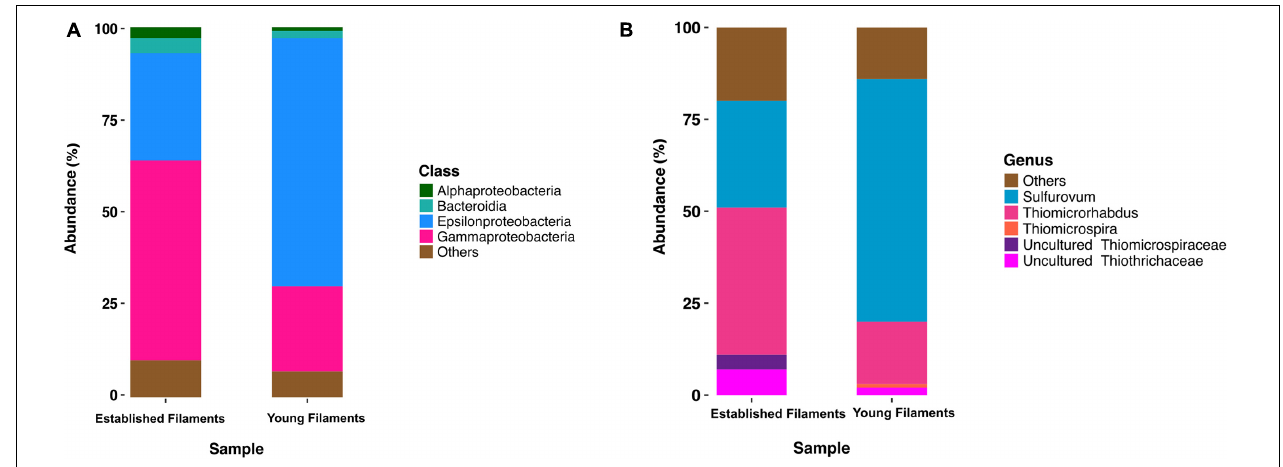
FIGURE 1 | Class (A) and genus (B) level distribution of 16S rRNA gene and transcript sequences recovered from established and young